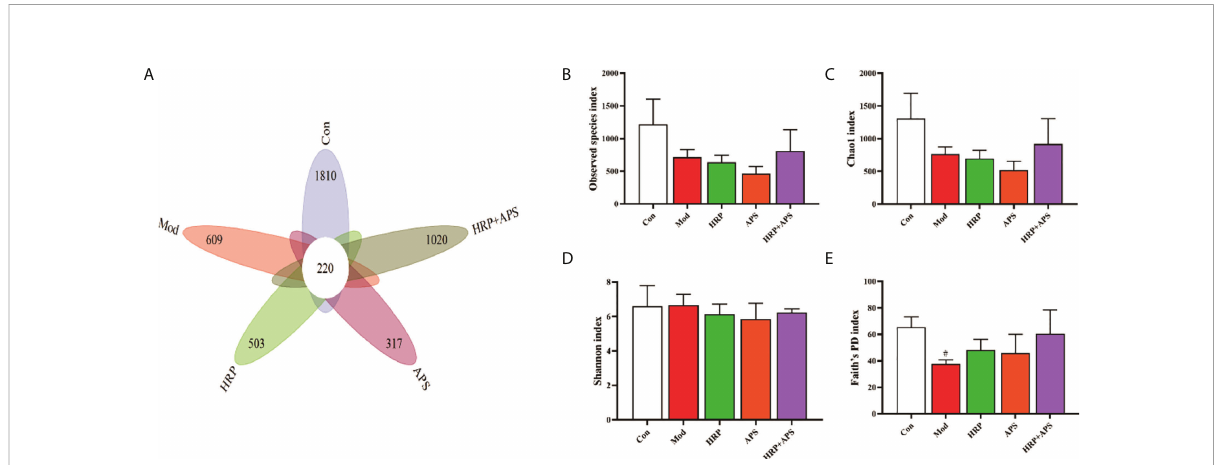
FIGURE 4 Effects of HRP, APS and the combination of HRP and APS on the number of OTUs and alpha diversity in mice intestinal mucosal bacteria. (A) The number of observed OTUs. (B) Observed species index. (C) Chao1 index. (D) Simpson index. (E) Faith ’ s PD index. # P < 0.05 vs.